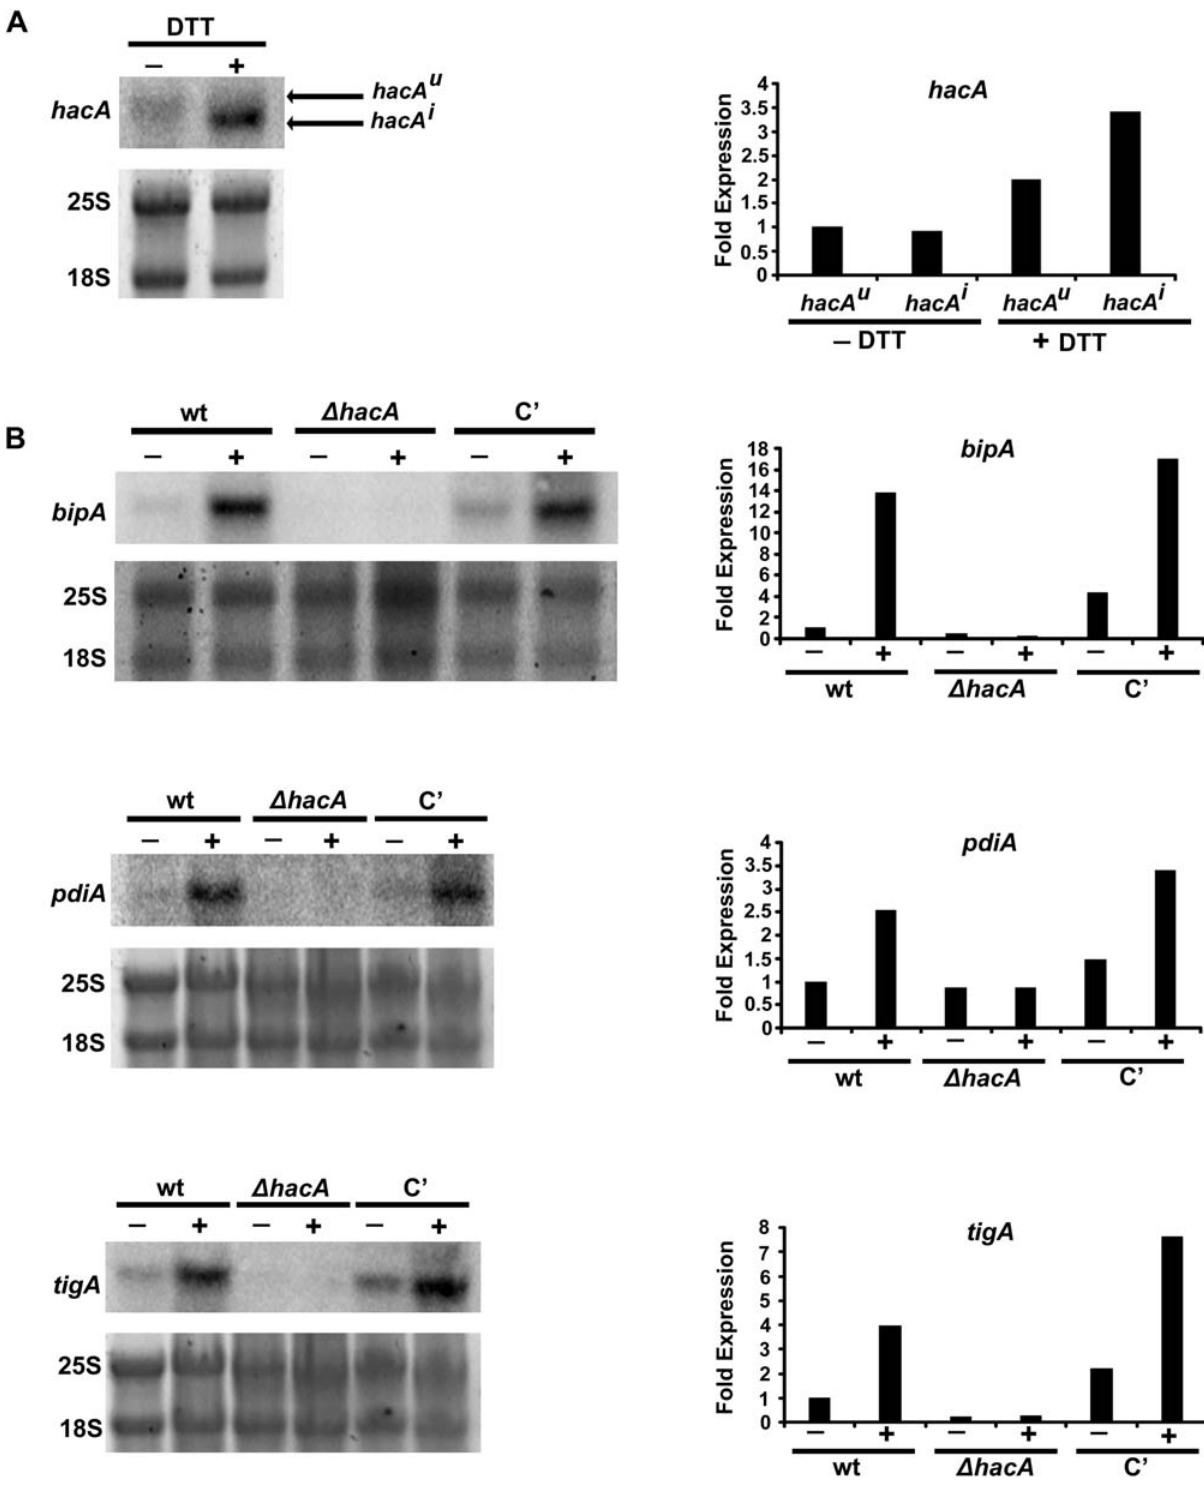
Figure 3. Loss of hacA disrupts UPR signaling in A.fumigatus . (A) Northern blot analysis of hacA expression and processing in the presence ( + ) or absence ( 2 ) of 1mM DTT for 1 h. Hybridization intensity was determined by phosphorimager analysis, and is presented graphically as fold expression relative to the levels of hacA u in the absence of DTT. (B) Northern blot analysis of UPR target gene expression ( bipA , pdiA , and tigA ) in the presence ( + ) or absence ( 2 ) of DTT. Hybridization intensity is presented graphically as fold expression relative to the wt strain in the absence of DTT.